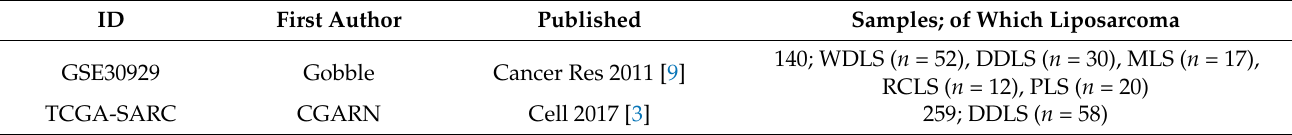
Table 1. Transcriptomics datasets analysed as part of the study.